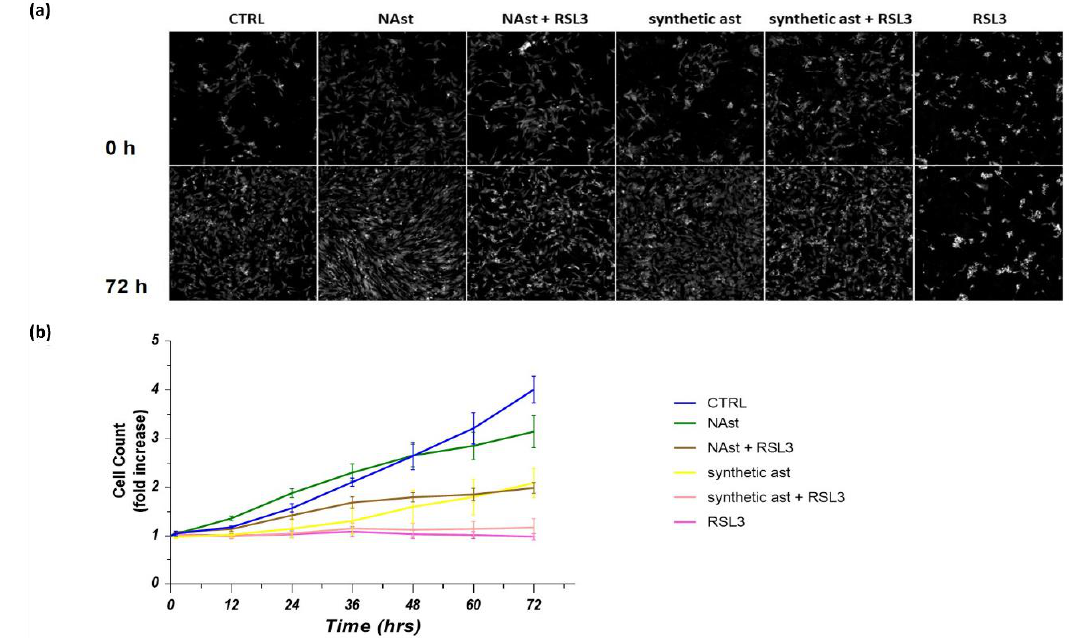
Figure 5. Quantitative phase imaging (QPI) and SHSY-5Y cell proliferation analysis. ( a ) Representative images of cells pretreated for 24 h with natural astaxanthin (NAst), synthetic astaxanthin (ast), and vehicle (ctrl), acquired at 0 h and after 72 h of incubation with RSL3. ( b ) Plot of cell count over time. Coloured lines are for control cells (blue line) and for cells treated with synthetic astaxanthin (yellow line), synthetic astaxanthin and RSL3 (pink line), NAst (green line), NAst and RSL3 (brown line), and RSL3 alone (purple line), for up to 72 h. Each time point represents the average of five independent wells ± SEMs. Scale bar: 200 µm.